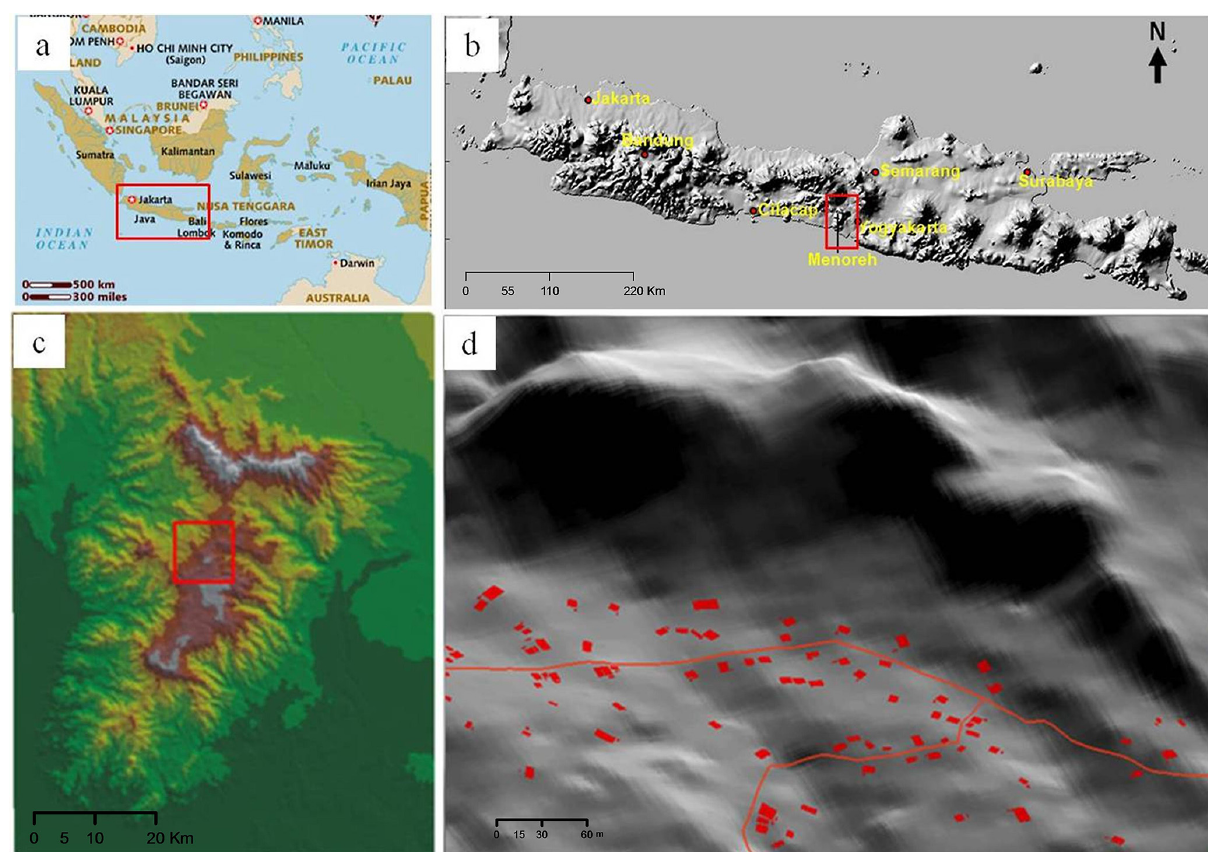
Figure 1. Study area (a) , geographical position of Java Island (b) , DTM of Java Island (c) , DTM of the Kulon Progo Dome (d) , Gunung Kelir area viewed from the east: red rectangles are elements at